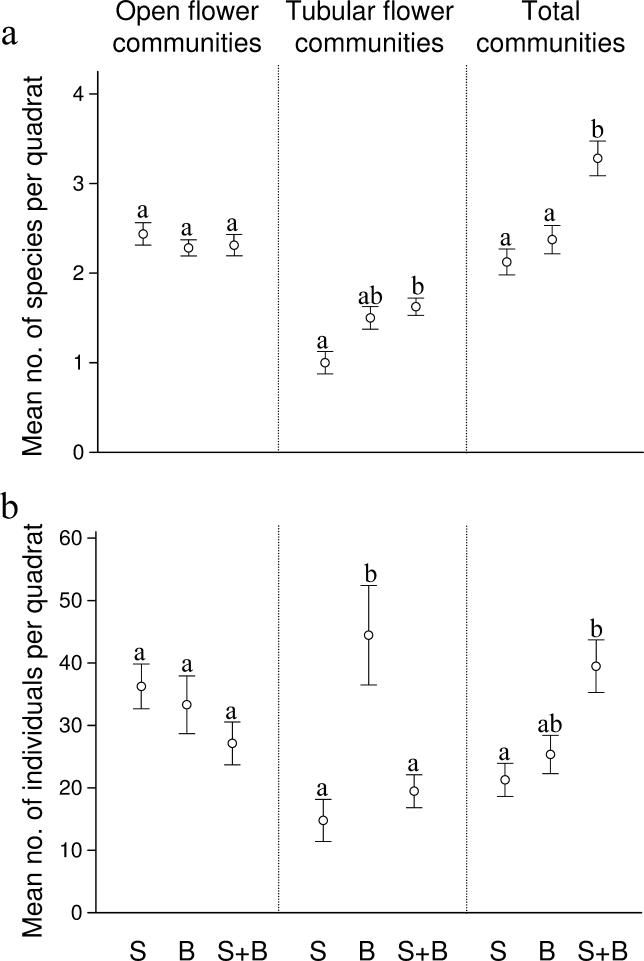
Effects of Pollination Treatments on Plant RecruitmentEffects of pollination by syrphid flies (S), bumble bees (B), or both (S + B) on (A) recruitment richness (mean number of plant species present as seedlings in a quadrat) and (B) recruitment density (mean number of plant individuals present as seedlings in a quadrat) in the various plant treatments. Error bars represent one standard error. Lower-case letters indicate statistically significant differences among pollination treatments within a plant treatment (Bonferroni-adjusted t-test, p < 0.05).